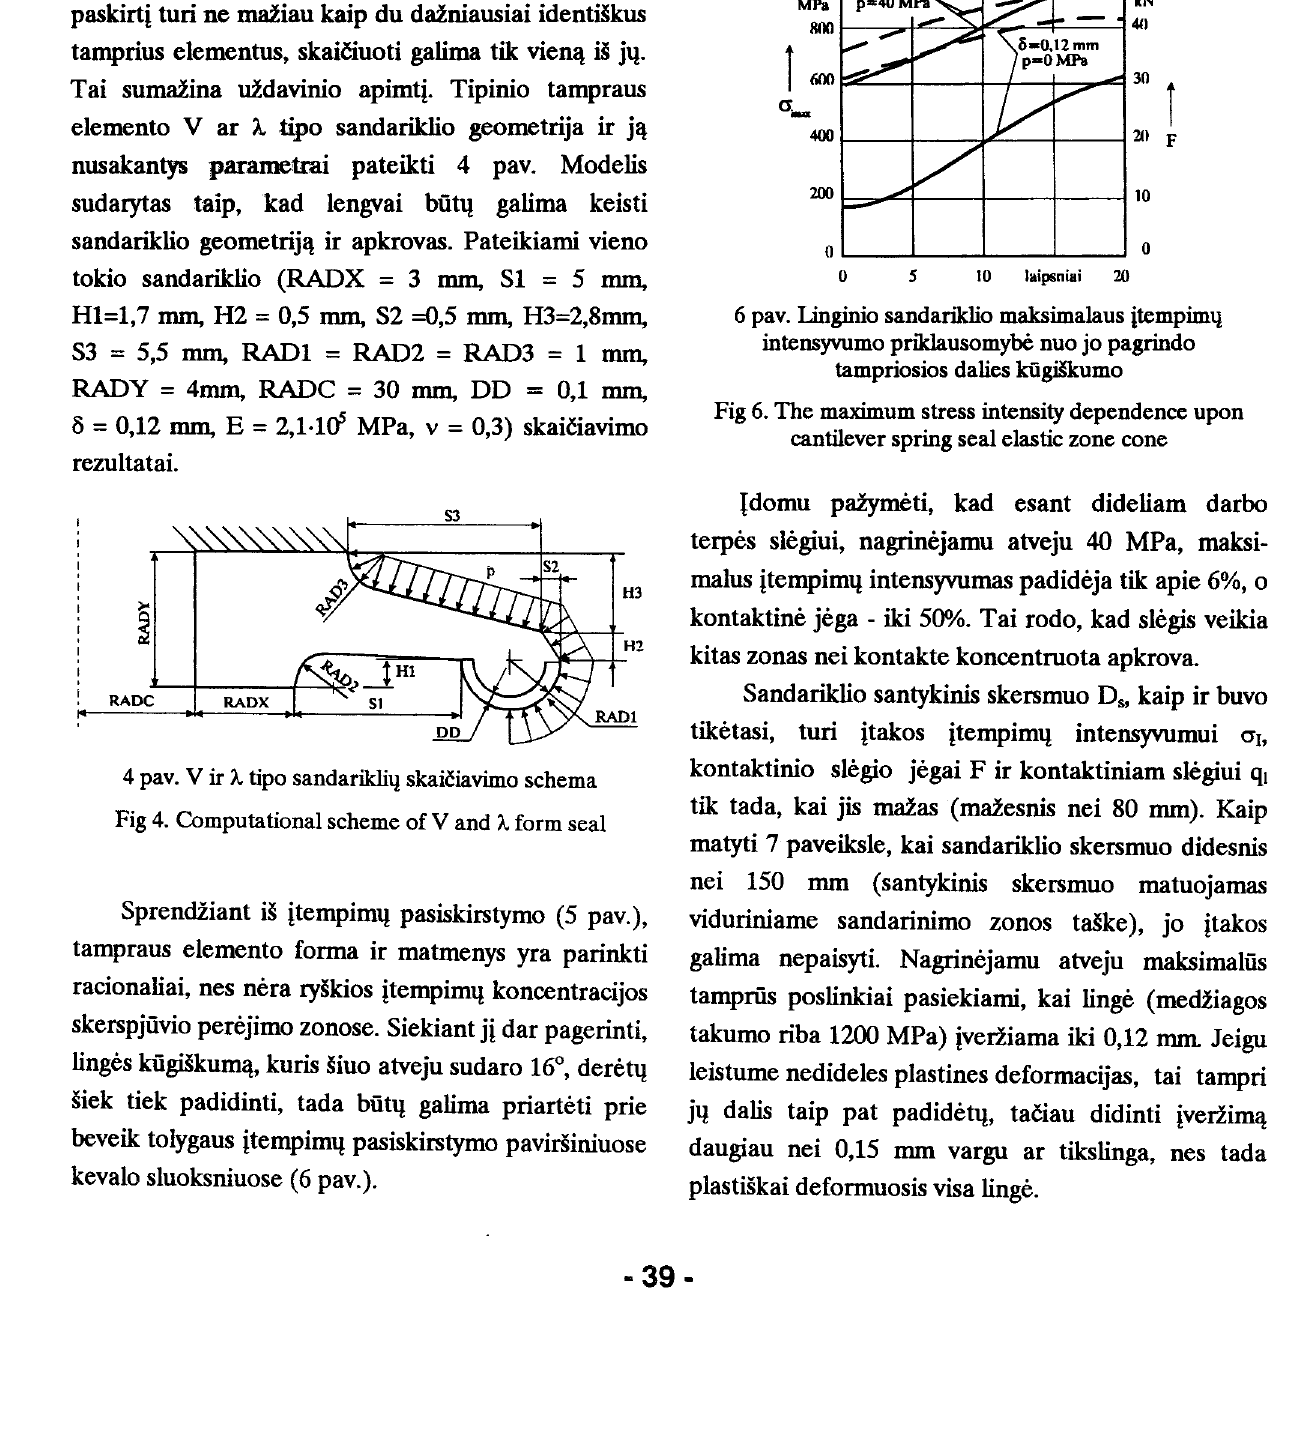
5 pav. linginio sandariklio itempimq intensyvumo Fig 5. Contours of stresses intensity of cantilever spring seal